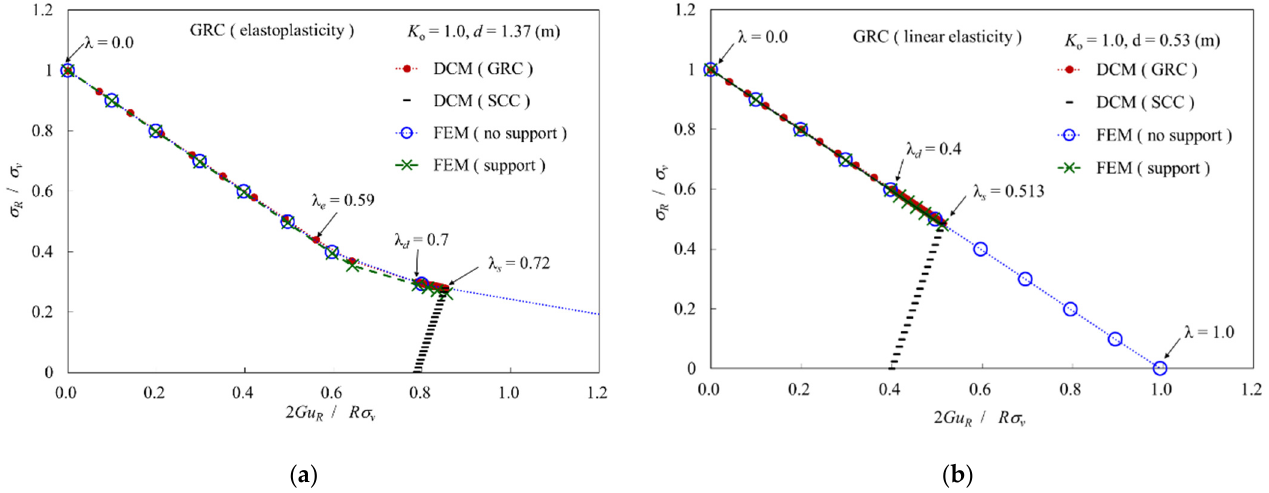
Figure 4. Comparison of results obtained between DCM and FEM. ( a ) in the plastic region (long unsupported span), and ( b ) in the elastic region (short unsupported span).